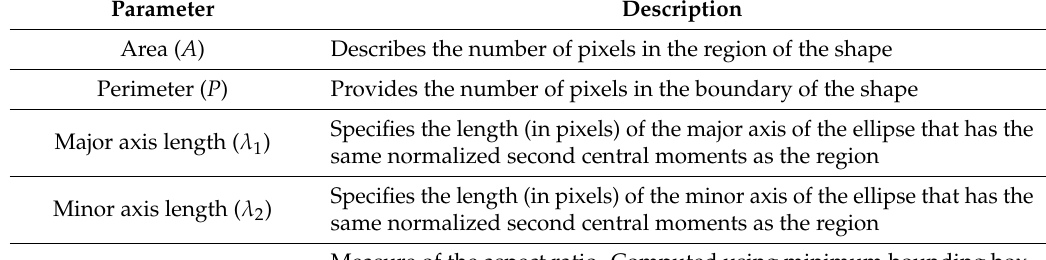
Table 4. Shape-related features extracted from the silhouette binary